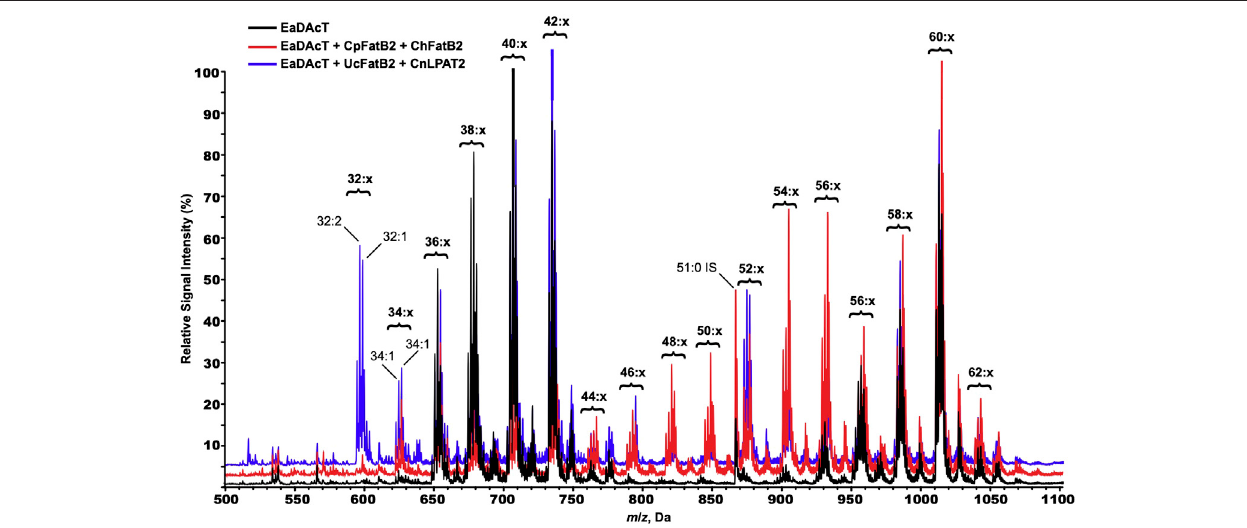
FIGURE 8 | ESI-MS spectra of neutral lipids extracted from F 3 seeds of representative lines expressing EaDAcT by itself (black), or in combination with CpFatB2 + ChFatB2 (red)or UcFatB+CnLPAT (blue).Signalpeakspossessthem/zvalueofthe[M+NH 4 ] + adduct.Forclarity,onlythenumberofacylcarbonsandnotthenumber of double bonds (x) in each series of acetyl-TAG and TAG molecular species is